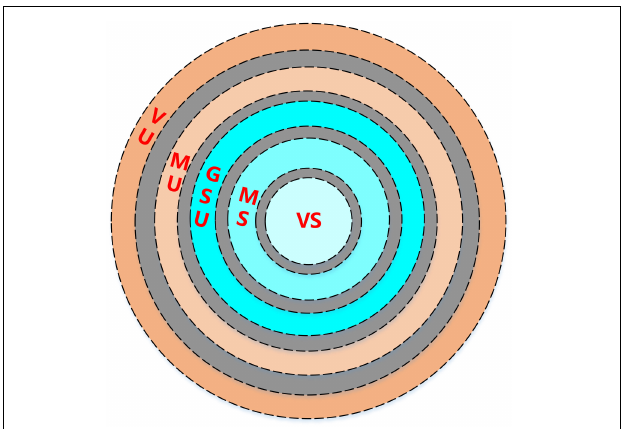
FIGURE 2 | Schematic diagram of state division.